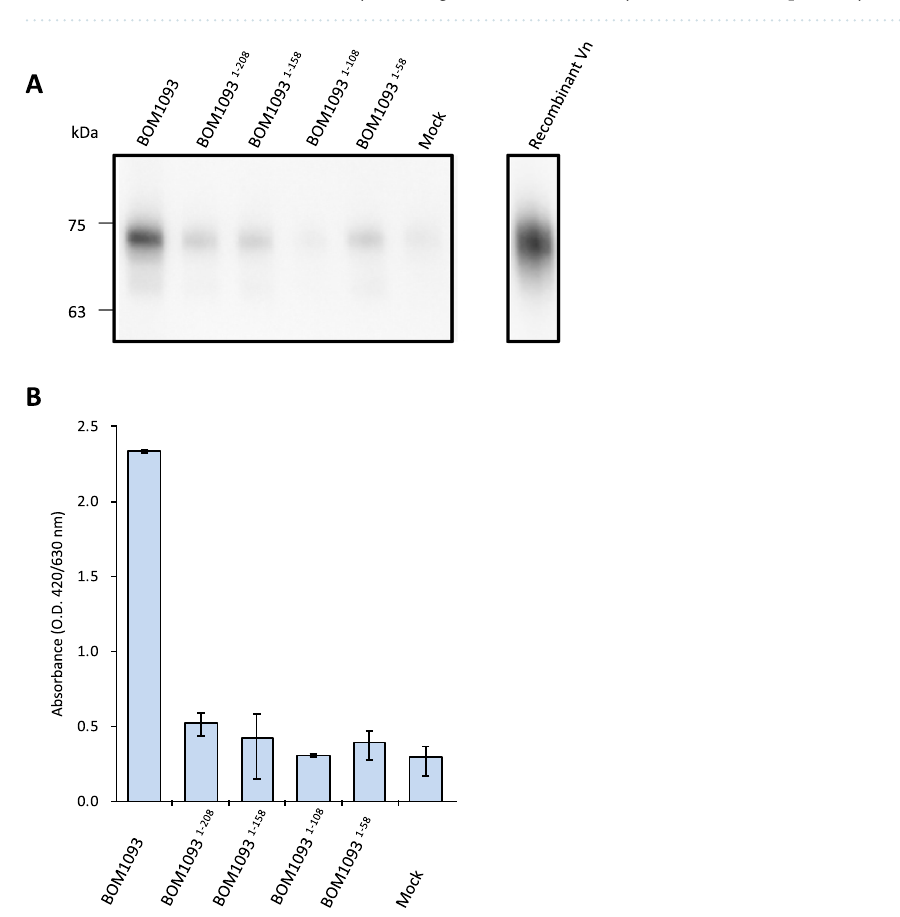
Figure 7. Decrease of serum Vn binding in C-terminal truncation mutants. B. garinii expressed BOM1093 or C-terminal truncation mutants were used in this study. B. garinii HT59G/pBSV2 was used as Mock control. ( A ) Detection of co-precipitated serum Vn by western blotting. M.W. indicated molecular weight marker. ( B ) The amount of co-precipitated Vn was quantified by